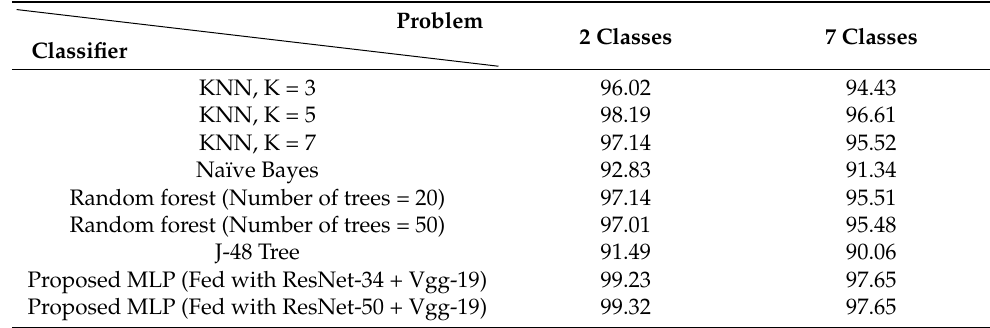
Table 4. The performance evaluation of proposed approach based on different classifiers on the Herlev dataset in terms of accuracy (%).